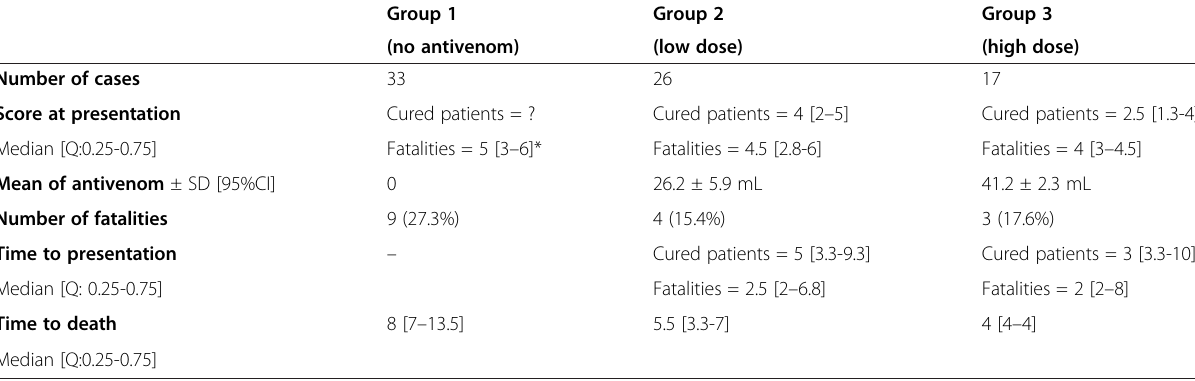
Table 5 Comparison of score and time to death in the 3 groups Group 1 Group 2 (no antivenom) (low dose) (high